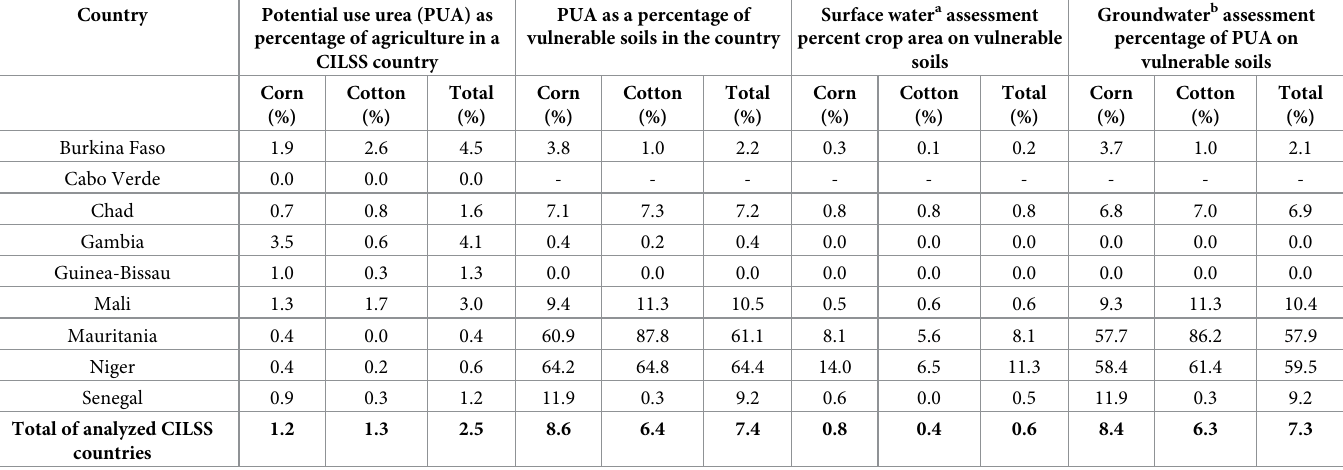
Table 2. Percentage potential use area, overlapping vulnerable soils, within proximity of surface water or overlapping shallow groundwater within the CILSS region analyzed. Country